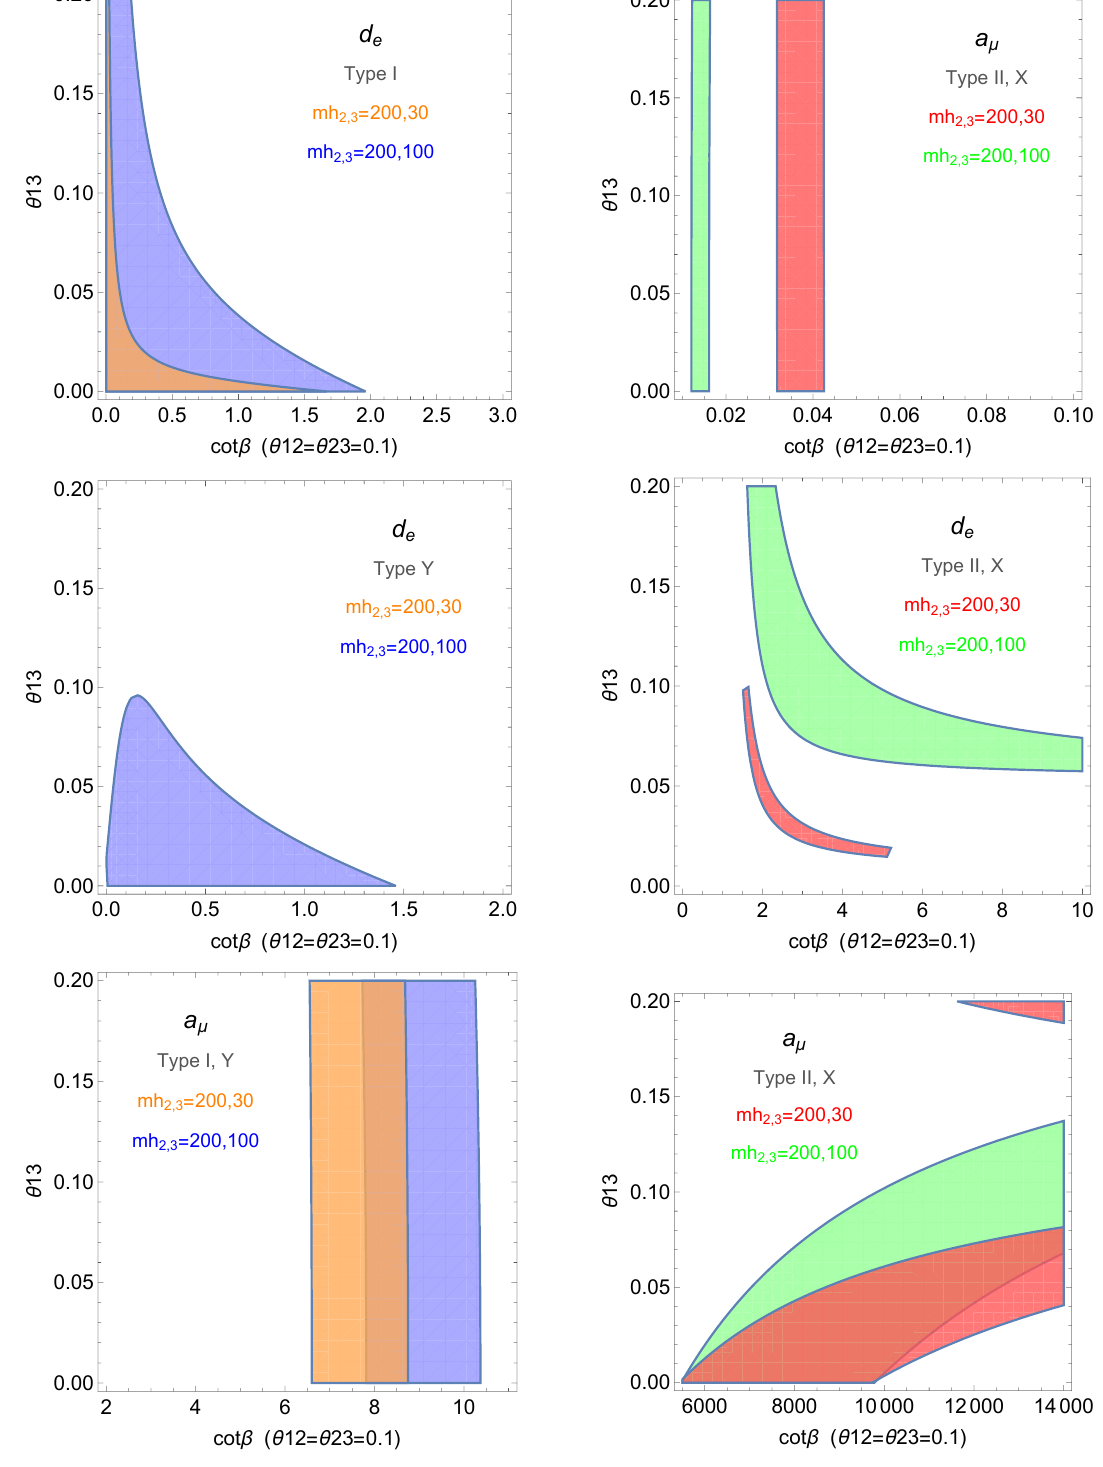
Figure 15 . Regions surviving d e bounds vs. regions producing a (cid:22) within the deviation observed in 2HDM Type I,Y (left) and Type II,X (right) for light scalar masses (in GeV) and (cid:12)xed (cid:18) 12 ; 23